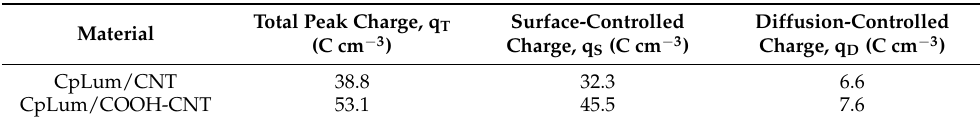
Table 4. Summary of surface- and diffusion-controlled contributions to peak charge for CpLum/CNT and